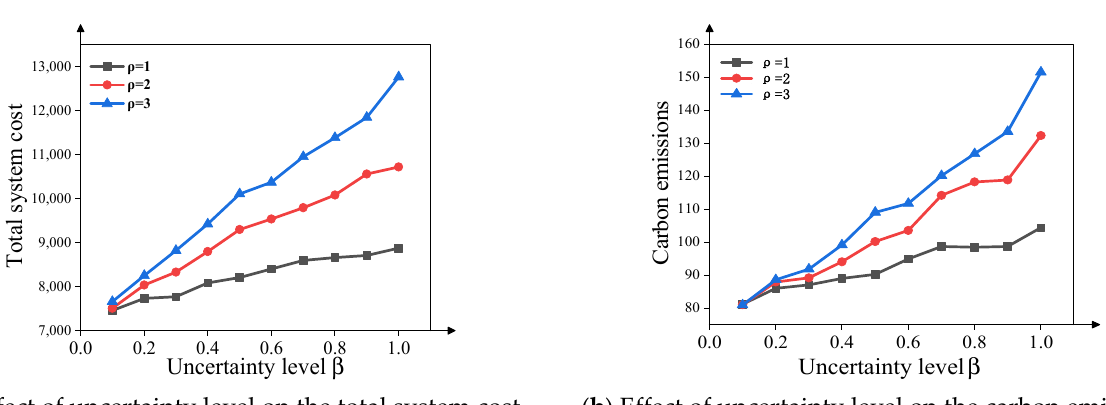
Figure 9. Effect of uncertainty level on the system performance.